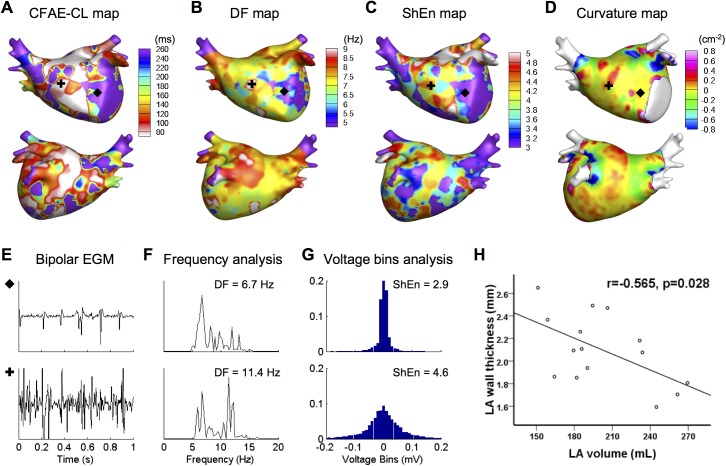
Three-dimensional color-coded mapping of AF wave-dynamics parameters and LA geometric parameter.(A) CFAE-CL, (B) DF, (C) ShEn, and (D) curvature maps. (E–G) Examples of fractionated and unfractionated EGM and their analyses. The frequency spectrum (F) and voltage histogram (G) were analyzed to compute the DF and ShEn of bipolar EGMs, respectively (recording sites are marked by black symbols). (H) An inverse relationship between mean LA wall thickness and LA volume. CFAE-CL, complex fractionated atrial electrogram-cycle length; DF, dominant frequency; ShEn, Shannon entropy; EGM, electrogram; LA, left atrium.